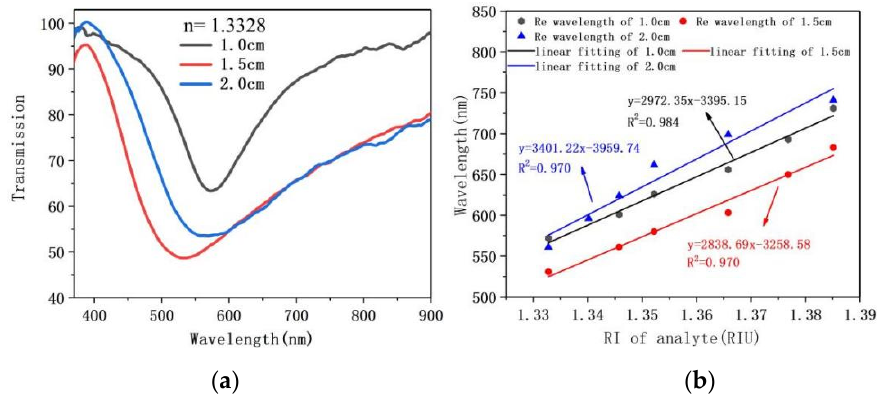
Figure 9. ( a ) Transmission spectrum of fiber/Ag film sensor at a refractive index of 1.3328 under different lengths of NCF (in cm); ( b ) Sensitivity fitting curve of fiber/Ag film sensor under different NCF lengths (in cm).